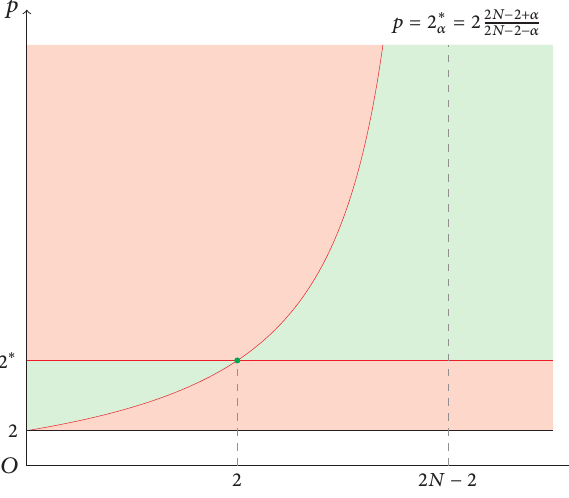
Figure 2. Existence (light green), nonexistence (light red) regions. Green dot means existence, red line means nonexistence.